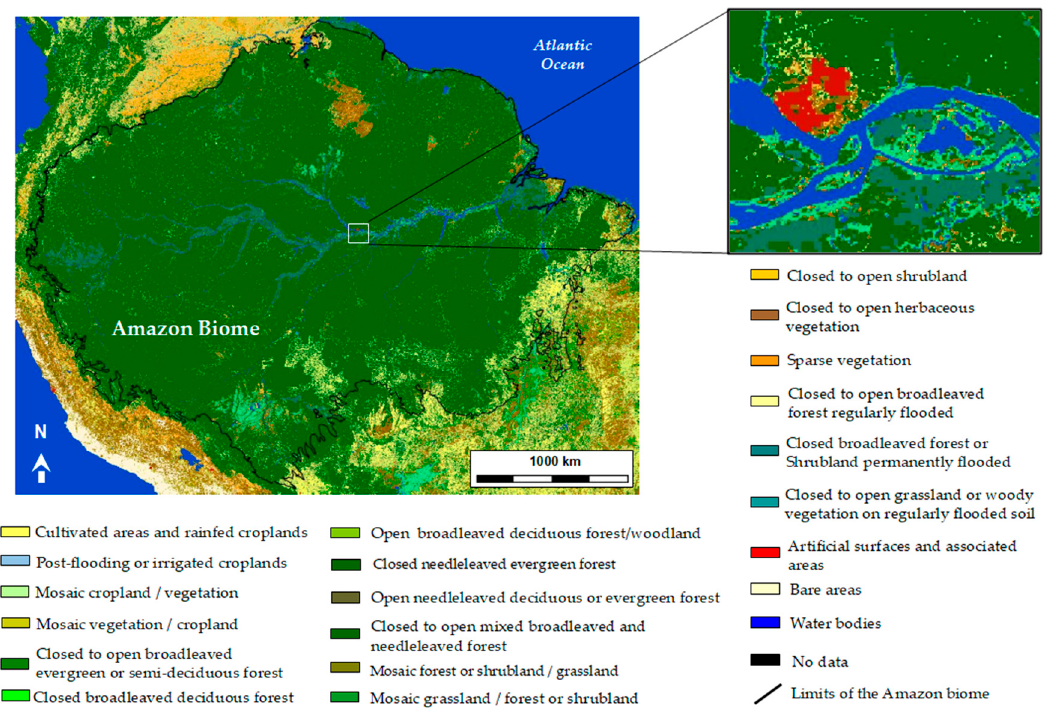
Figure 2. Land cover map (300 ‐ m resolution) of the Amazon biome extracted from the 2009 land cover world map produced in the framework of the ESA GlobCover project (credits: ESA/ESA GlobCover Project, led by MEDIAS France/Postel; see http://www.esa.int/spaceinimages/ Images/2008/12/Envisat_global_land_cover_map for high ‐ resolution access to the map and the legend).